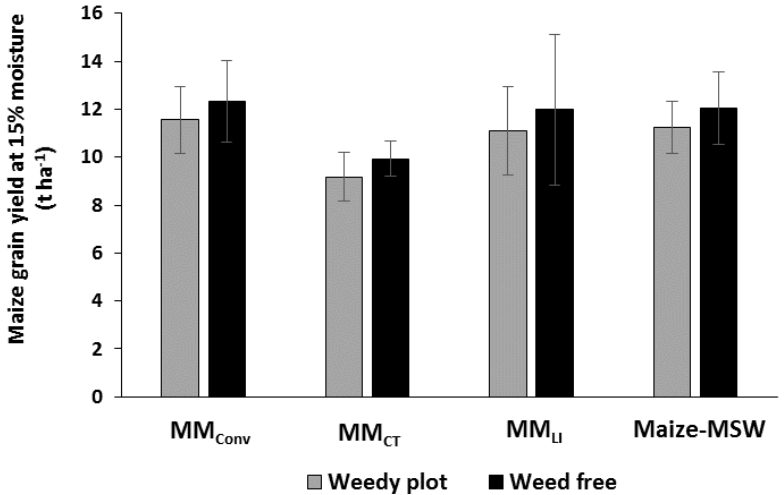
Figure 4. Mean maize grain yield (at 15% water content, t ha − 1 ) in the presence or absence of weeds (weed ‐ free zones, hand ‐ weeded, N = 4 quadrats in each zone and cropping system) assessed in 2014 and 2015 for each cropping system (MM Conv : conventional maize monoculture; MM CT : conservation tillage maize monoculture; MM LI : low ‐ input maize monoculture; Maize ‐ MSW: integrated maize rotation). Error bars represent standard deviations. ANOVA: hand weeding effect ( p < 0.05); cropping system effect (non ‐ significant).